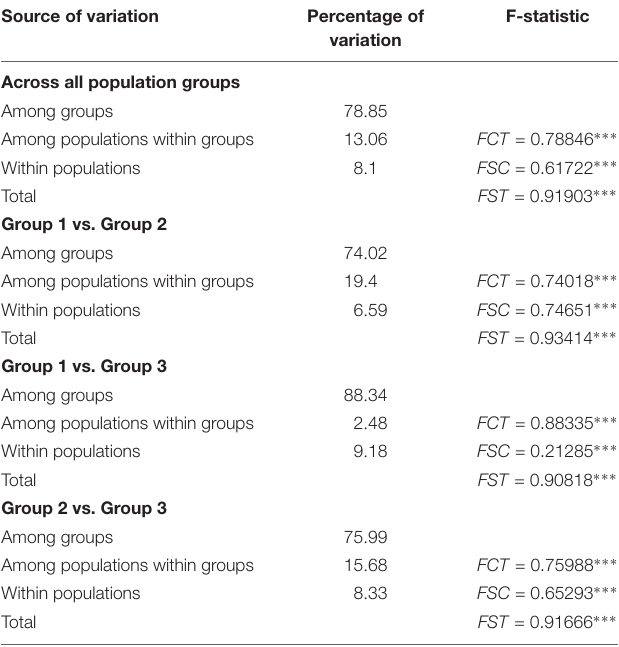
TABLE 3 | Structure of genetic variation within and among three SAMOVA-derived